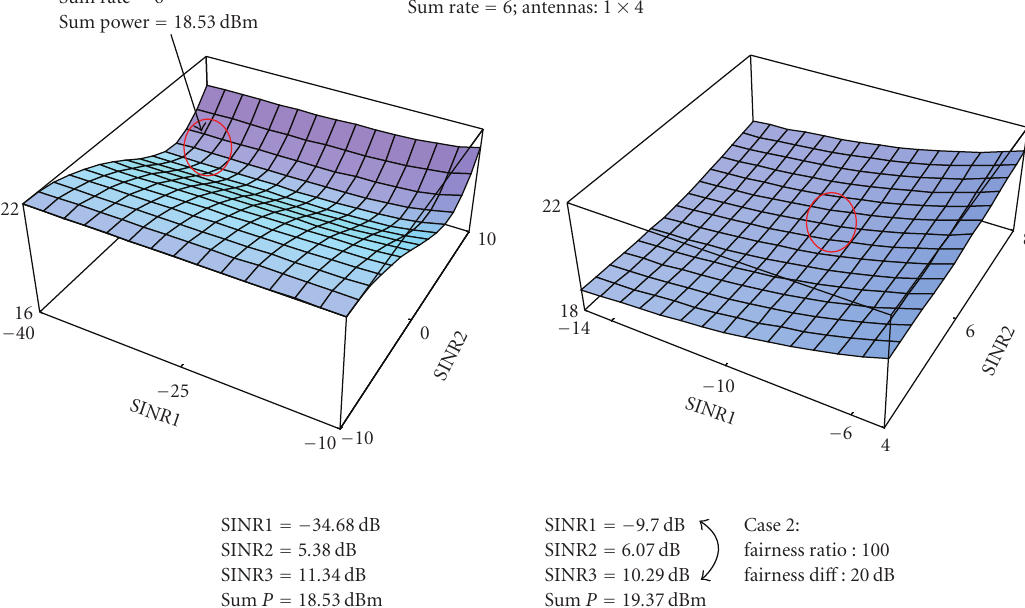
Figure 6: Sum power minimization for the 1 × 4 SIMO case. Compared with the 1 × 2 case (Figure 2), we notice that approximately half of the power is required to reach the same sum rate target (18.53 dBm = 71.2mW).